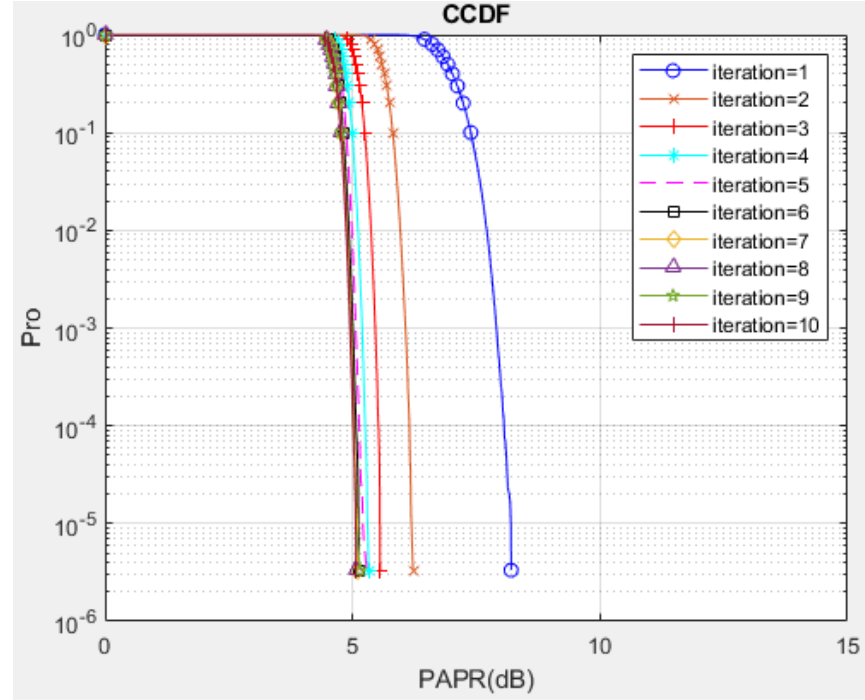
Figure 11. CCDF vs. α for a different iteration number for the proposed I–TR scheme.